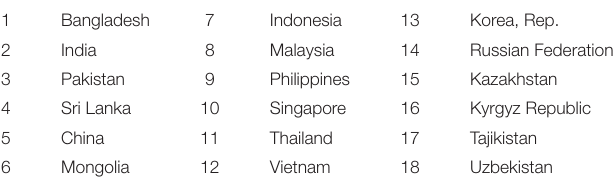
TABLE 2 | List of